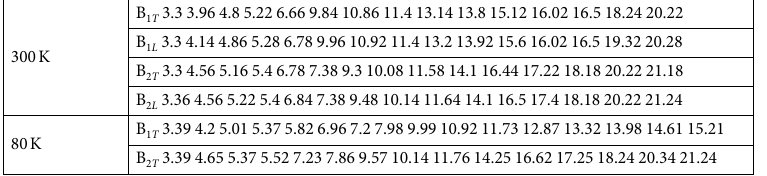
Table 1. Low-frequency Raman modes of LiB 3 O 5 in units of THz at 300 K 20 and 80 K 22